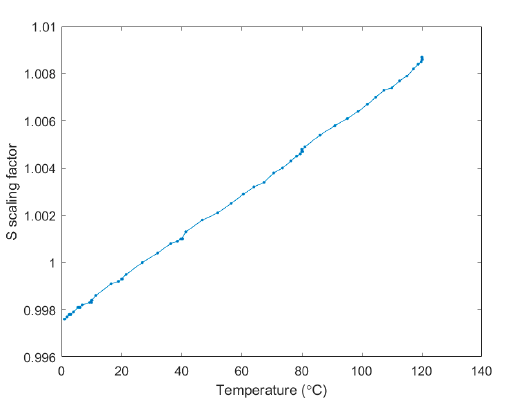
Figure 8. Measured sensor response versus temperature from 0 °C to 120 °C.